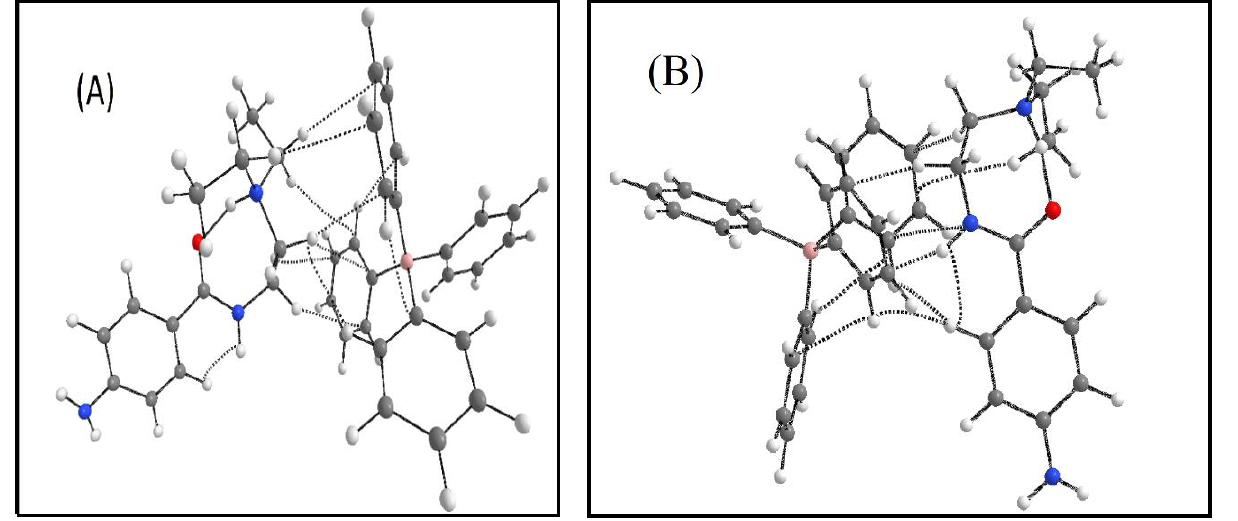
Figure 7. Topological atoms in molecules (AIM) graph of both PR-TPB complexes, configuration for: (A) complex S1 and (B) complex S2.